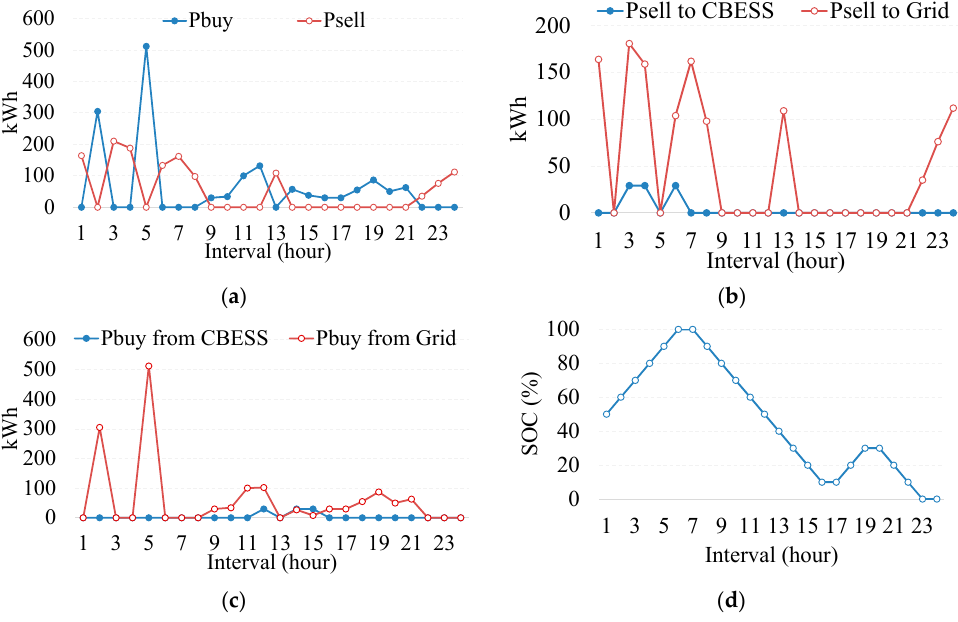
Figure 6. External trading from the microgrid (MG): ( a ) total trading amount from the MG; ( b ) selling power from the MG to CBESS and grid; ( c ) buying power of MG from CBESS and grid; ( d ) centralized-based operation of CBESS.